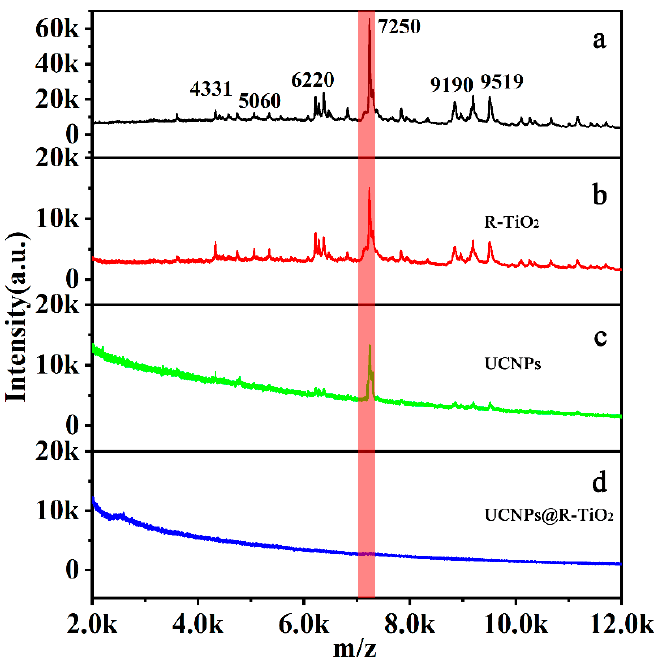
Figure 5. MALDI-TOF MS analysis of E. coli without ( a ) and with R-TiO 2 ( b ), UCNPs ( c ), and UCNPs@R-TiO 2 composites ( d ) under 980 nm NIR light irradiation for 20 min (40 μ g/mL). The red band is the characteristic peak of E. coli at m/z = 7250.